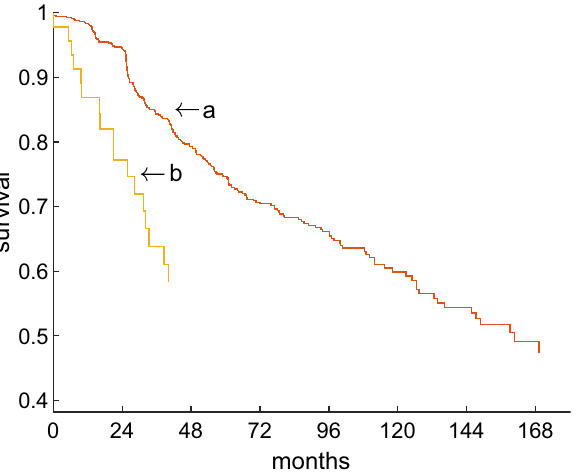
Figure 8. Precise versus inadequate treatment based on hormone receptor status. Survival free from recurrence, according to Kaplan–Meier. Red: Patients treated correctly as receptor positive (flow (a) in Fig. 7). Ochre: Patients erroneously assigned positive (flow (b) in Fig. 7).